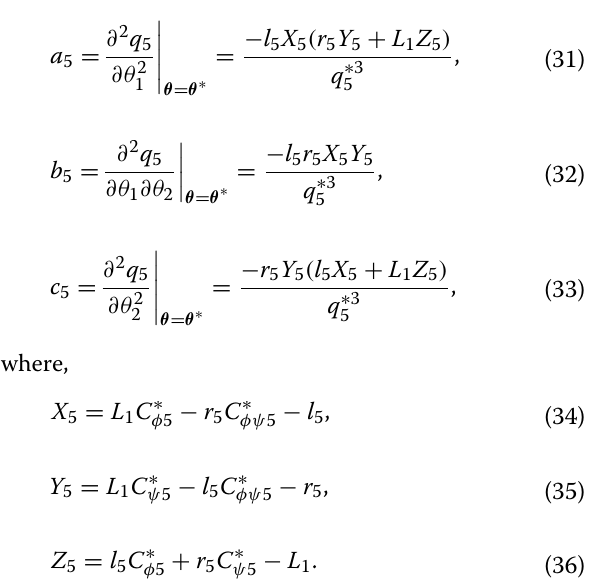
joint to the muscular fixed points l ˜ r ˜ i and i l ˜ i r ˜ i l ˜ i and the 1st link The angle between r ˜ i and the 1st